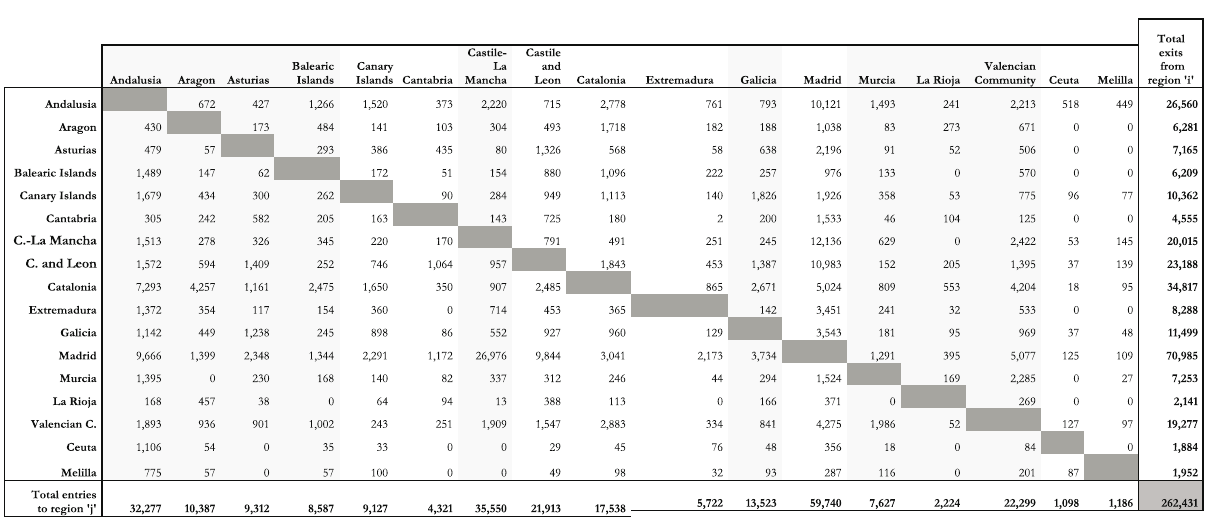
*Shaded in grey, the regions with more high - income taxpayers entering in 2012 than leaving ( after residing there in 2006 ) . Source: by the authors, based on the IRPF Panel.